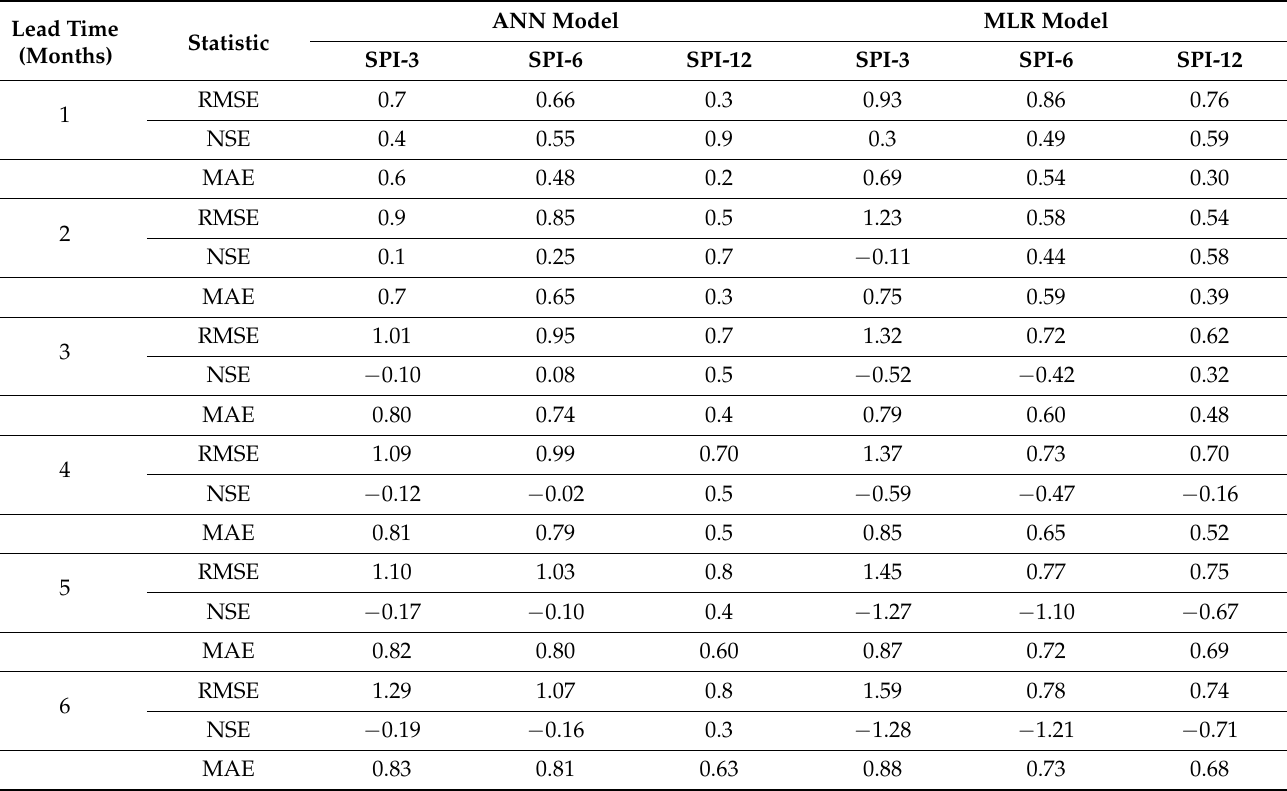
Table 3. Performance of standalone